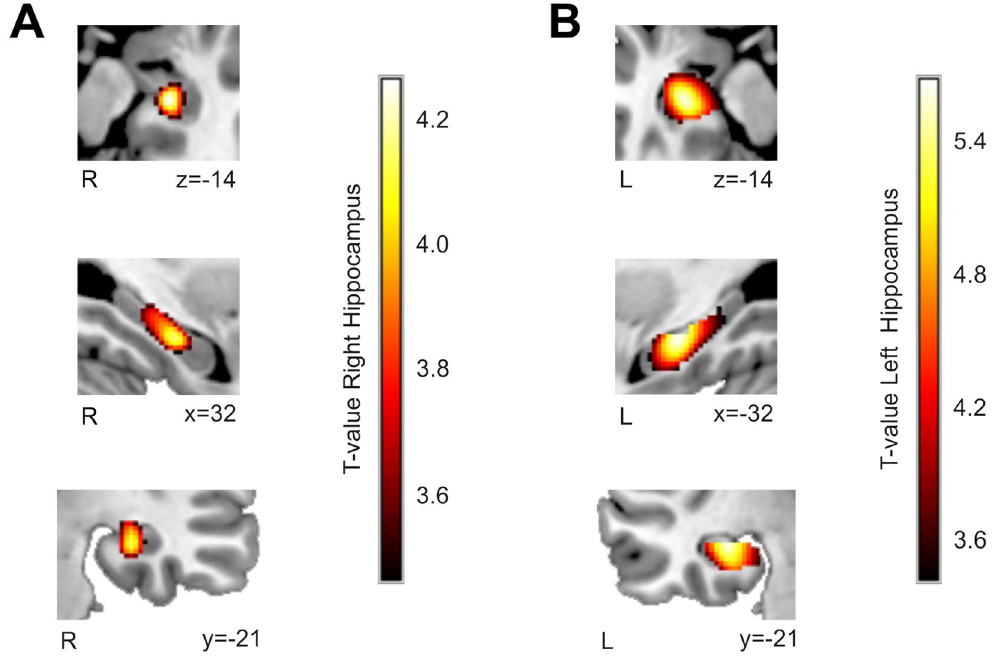
Figure 1. Voxel-Based Morphometry comparison between groups: ( A ) control > right TLE + UHS patients and ( B ) control > left TLE + UHS. Both groups of patients showed a decreased hippocampal grey matter compared to healthy participants. Results are shown in red-yellow at an auxiliary p < 0.005 uncorrected threshold at the voxel level (main peaks in both clusters survived a Family-wise error Correction for Small Volume p < 0.05 threshold). Neurological convention is used with Montreal Neurological Institute (MNI) coordinates at the bottom right of each slice. R, Right Hemisphere; L, Left